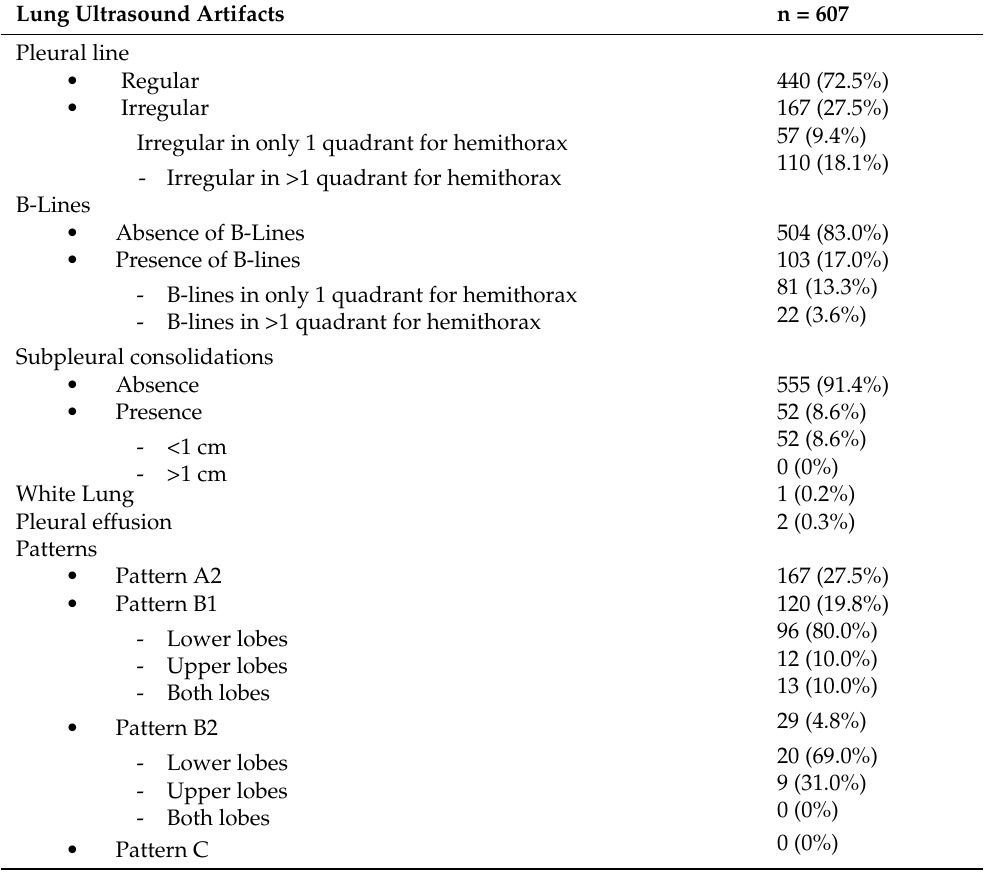
219 (36.1%) We observed irregular pleural lines in 27.5%, B-lines in 16.9%, and subpleural consoli- dations in 8.6% of the cases. These artifacts were observed more frequently in the lower lobe projections, particularly patterns B1 and B2 in lower lobes were observed in 80% and 69%, respectively ( p < 0.001) (Table 2). Table 2. Rates of patterns and artifacts lung ultrasound at